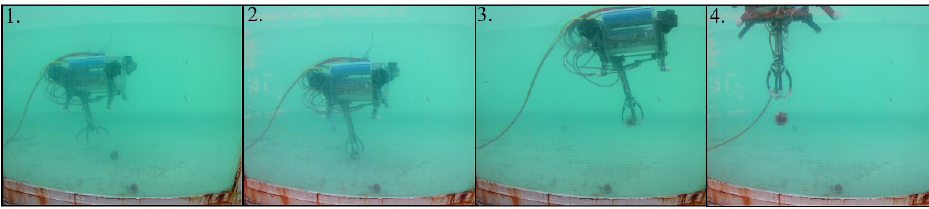
Figure 14. Practical results of catching the ball. The numbers are given according to the proposed stages in the methodology.